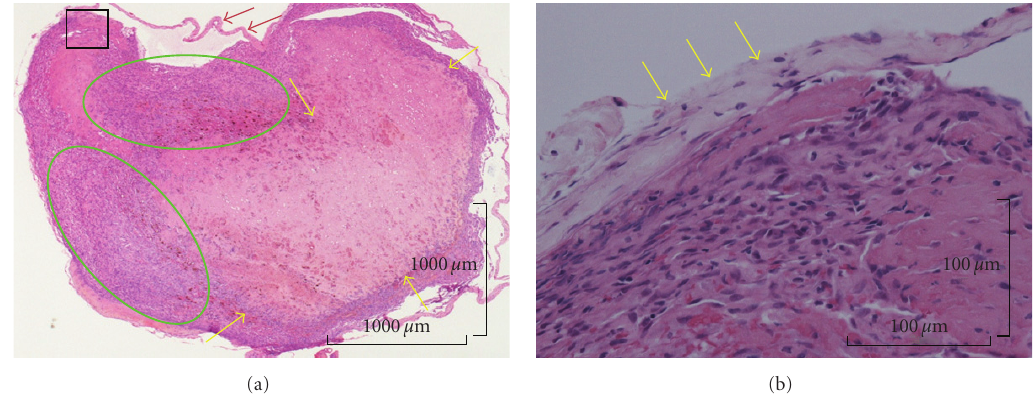
Figure 3: (a) A thrombus (inside green circles) was observed in the expanded blood vessels (blue arrows) with venous pool (yellow arrows) using hematoxylin-eosin staining (Original magnification, × 3.2; Bar, 1000micro meter). (b) The figure shows the area inside the black square of Figure 2(a). Proliferated endothelial papillary cells were observed. Expanded elastic fibers (yellow arrows) are present on the blood vessel surface using hematoxylin-eosin staining (Original magnification, × 16; Bar, 100 micrometer).